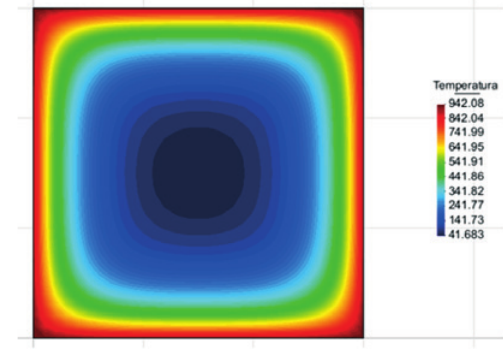
Figura 14b Seção transversal com 8 ϕ 16 mm